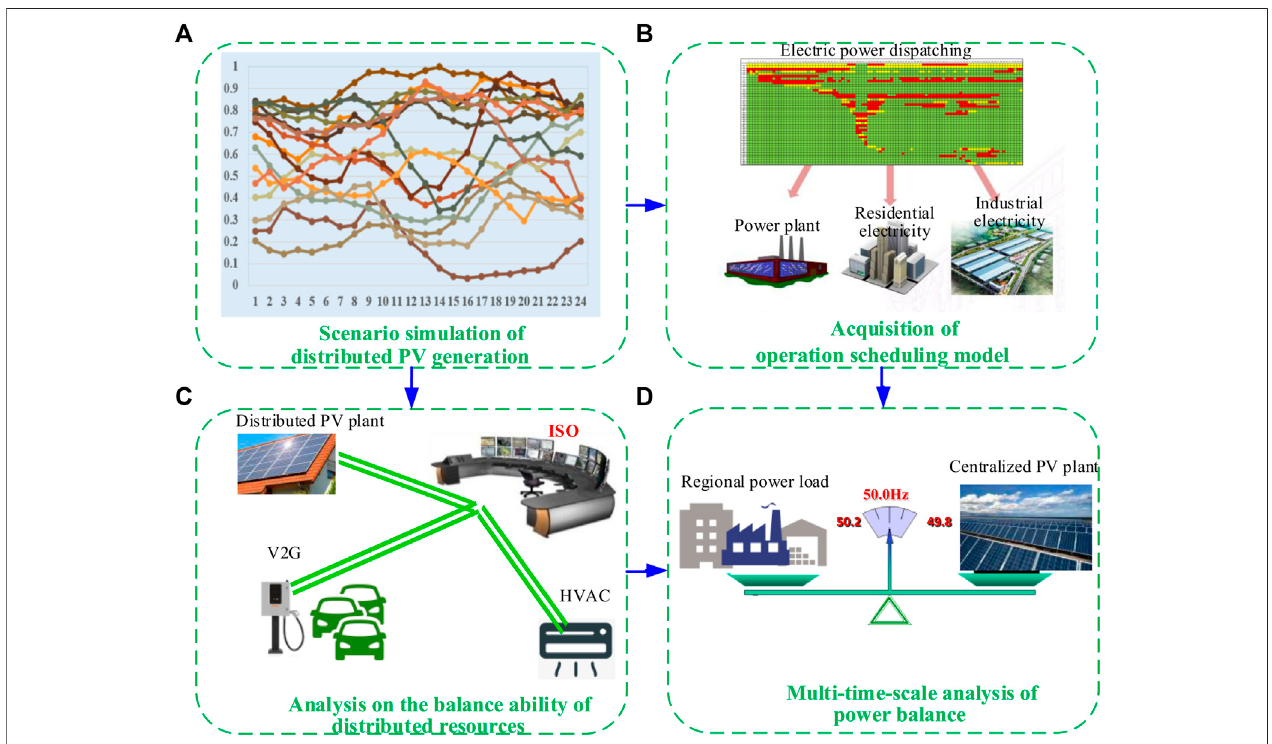
FIGURE 1 | Framework for multi-time-scale power balance considering centralized PV generation. (A) Scenario simulation of distributed PV generation. (B) Acquisition of operation scheduling model. (C) Analysis on the balance ability of distributed resources. (D) Multi-time-scale analysis of power balance.